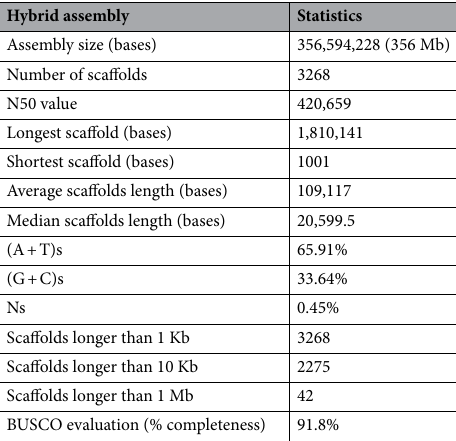
Table 1. Assembly statistics of the A. occidentale genome.